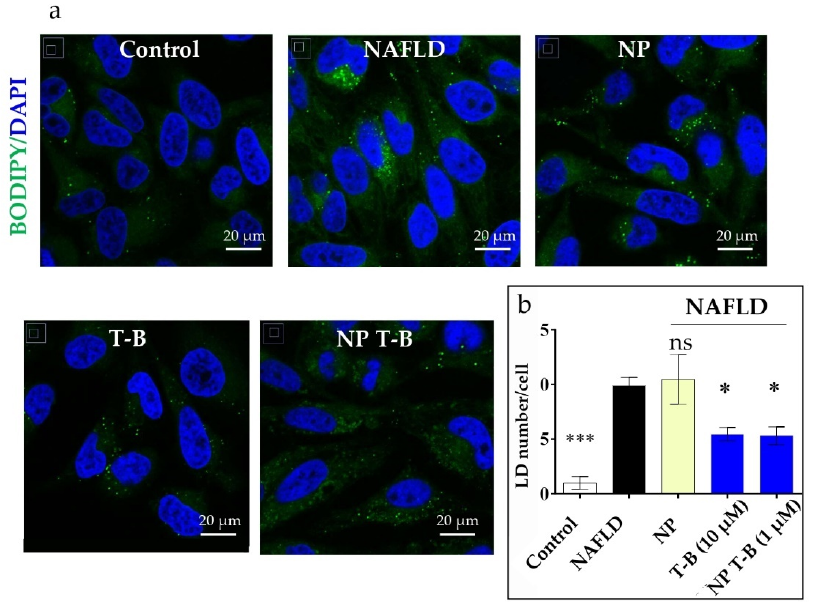
Figure 6. Effect of T-B and different formulation treatment on lipid droplet (LD) number in an NAFLD model in HeLa cells. ( a ) Representative images. HeLa cells were treated with fatty acids (OA/PA 0.8 mM/0.4 mM) for 24 h to induce LD formation and subsequently treated for 16 h with T-B (10 µM), NP T-B (1 µM) or NP. Fixed cells were stained with Bodipy (493/503) for lipid droplets (in green) and DAPI for nuclei (in blue) and imaged with a confocal microscope. Scale bar, 20 µm. ( b ) Quantification of lipid droplets (green dots) per cell for all conditions. LDs were quantified with the ICY software. Values are the means ± s.e.m. from replicates counting at least 250 cells. * p ≤ 0.05, *** p ≤ 0.001; ns: non-significant by one-way ANOVA and Dunnett’s multiple comparison test (all compared to NAFLD).